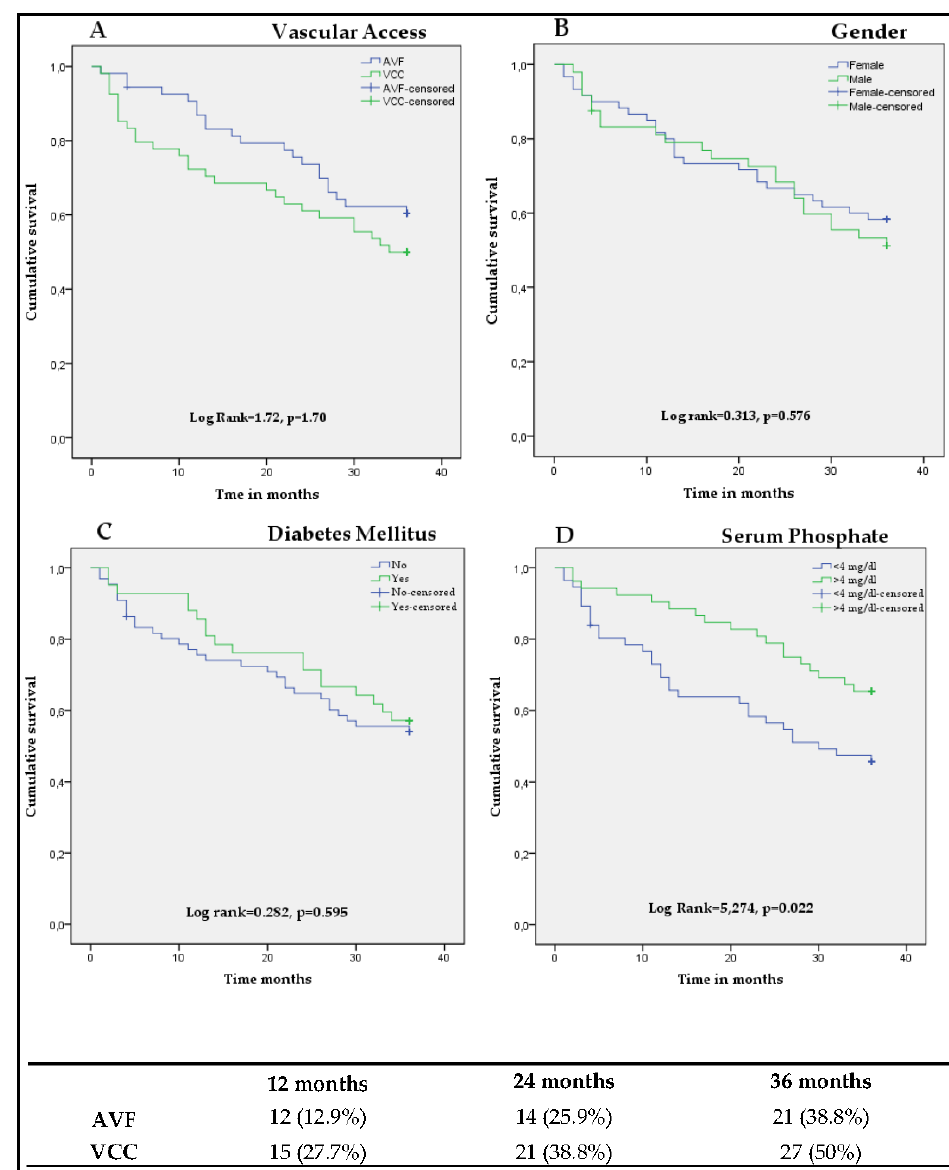
Figure 1. ( A – D ). Kaplan Meyer curves, comparing survival according to venous access, gender, diabetes mellitus and serum phosphorus levels (<4 mg/dL or >4 mg/dL) using the Log Rank test. The percentages of deaths at 12, 24, 36 months are described for patients with AVF and VCC.